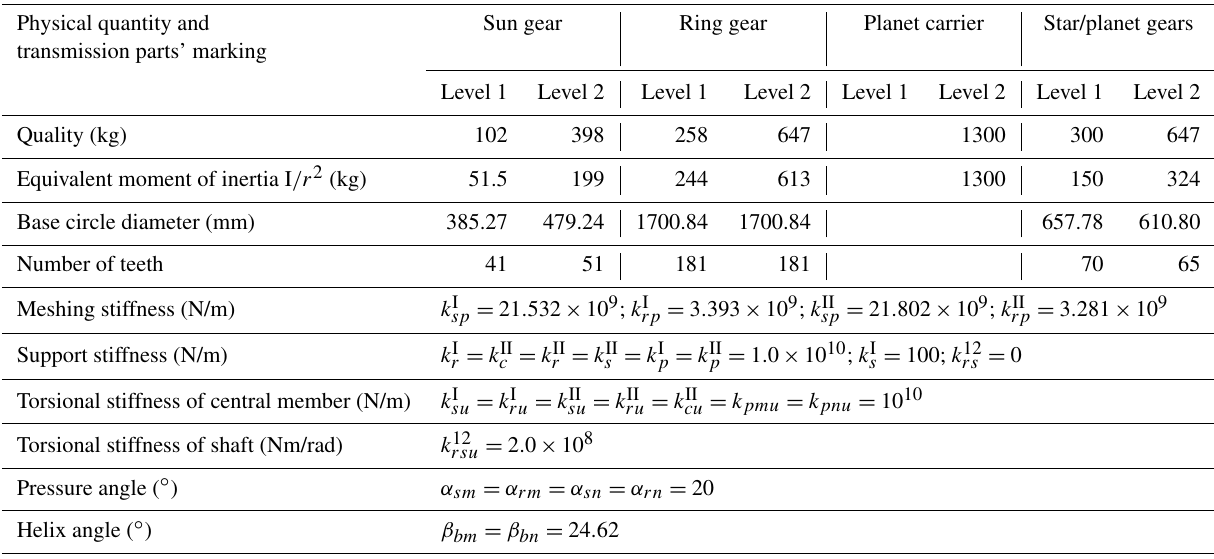
Table 1. System parameters. Physical quantity and